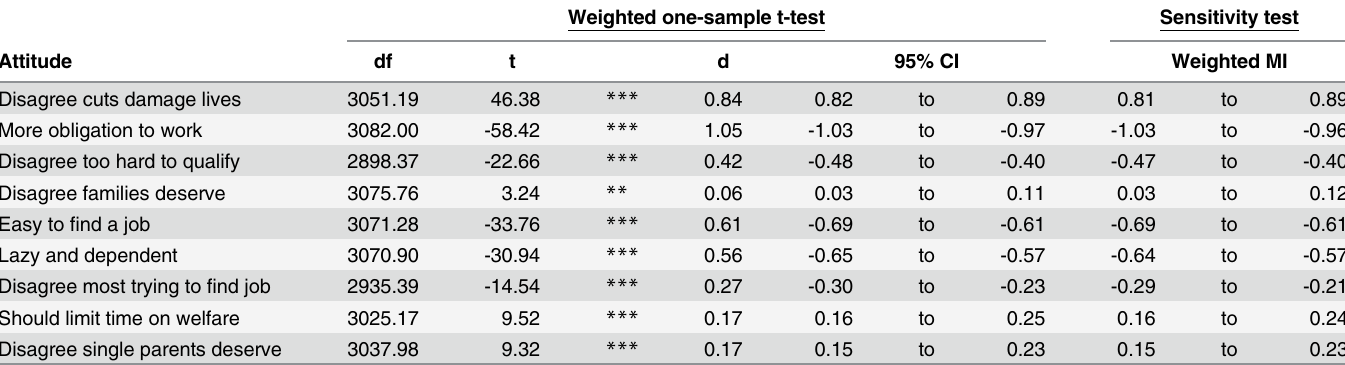
Table 3. Tests of attitude